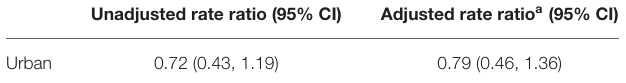
TABLE 2 | Geography status and rate of being socially isolated. Unadjusted rate ratio (95%